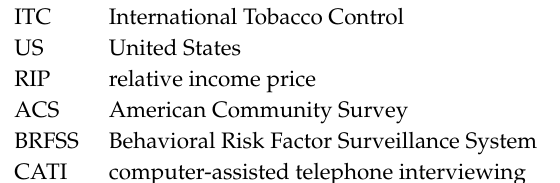
s1, Figure S1: Process used to impute a continuous measure of income for smokers participating in the ITC US Survey (Waves 2–9) using proxy data from a contemporaneous American Community Survey. Figure